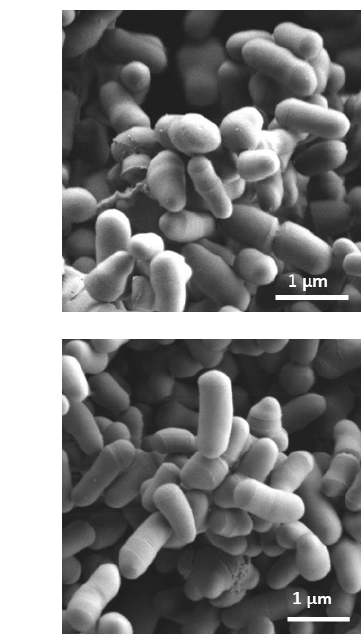
Figure 7. Scanning electron micrographs of P. freudenreichii CIRM-BIA 129. ( A ) Control bacteria. ( B ) Bacteria pretreated with 0.1% Tween ® 80 and then exposed to 25 ppm Pb(II). The scale bar corresponds to 1 µm.